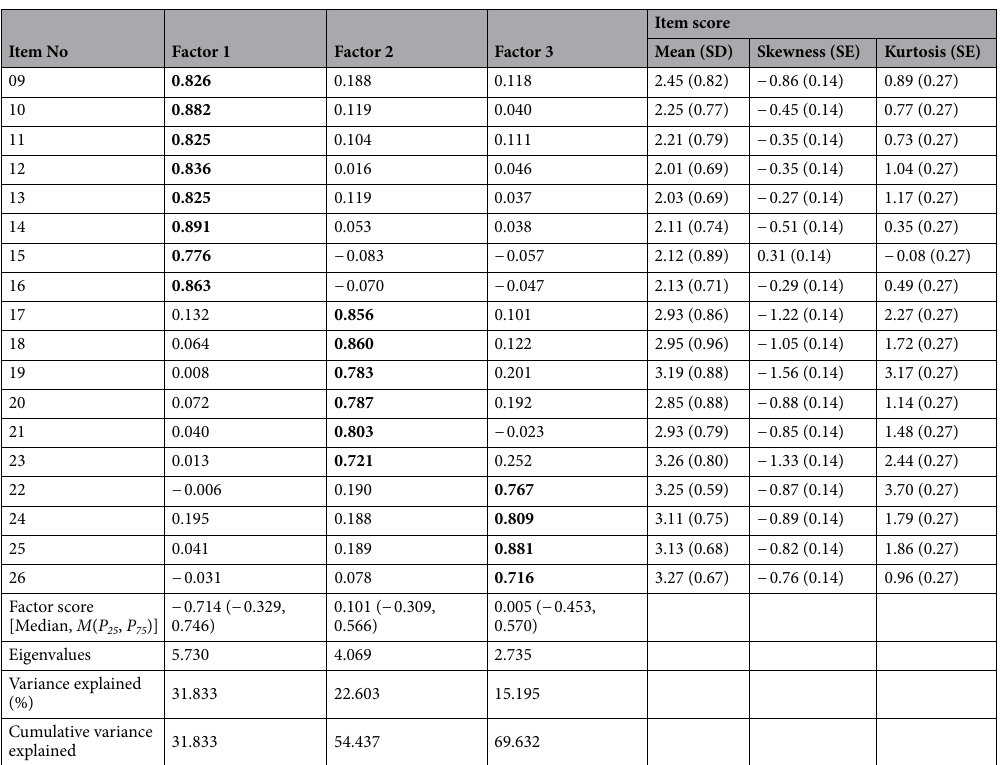
Table 2. Factor loadings of the EFA. Varimax was the applied rotation method. Factor loadings with absolute values higher than 0.5 are in bold. Factor 1: Risk perception, Factor 2: Perceived benefits and intention to change physical activity, and Factor 3: Perceived benefits and intention to change dietary